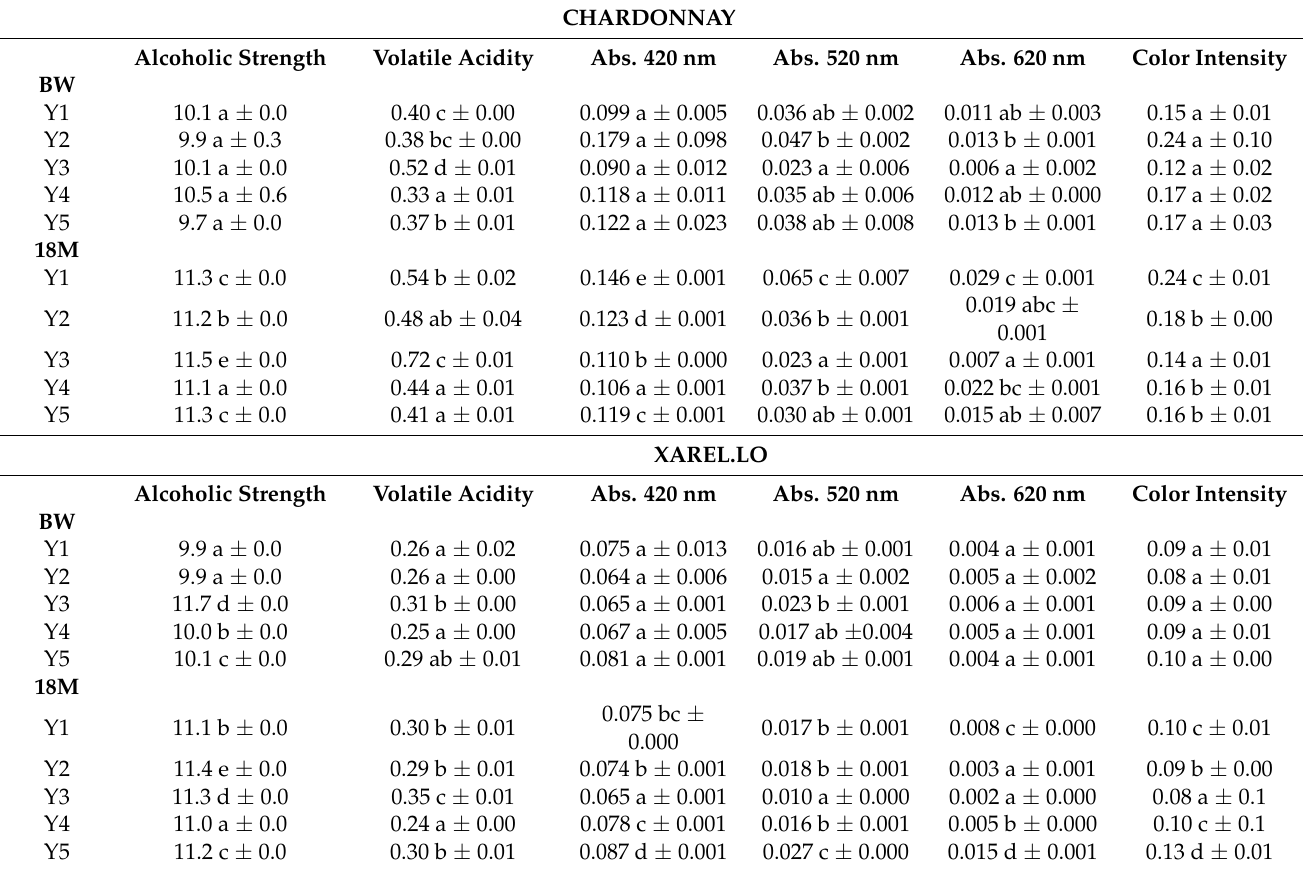
Table 1. Basic analysis of Chardonnay (CH) and Xarel.lo (XA) base wines (BW) and cavas after 18 months of aging on lees (18M), with the addition of five different S. cerevisiae (Y1, Y2, Y3) and non- Saccharomyces (Y4 and Y5) yeasts. Different letters indicate significant differences between samples with different yeasts for each grape variety, and in each of the analysis times. Units: alcoholic strength (%vol) and volatile acidity (g/L). Samples (n =